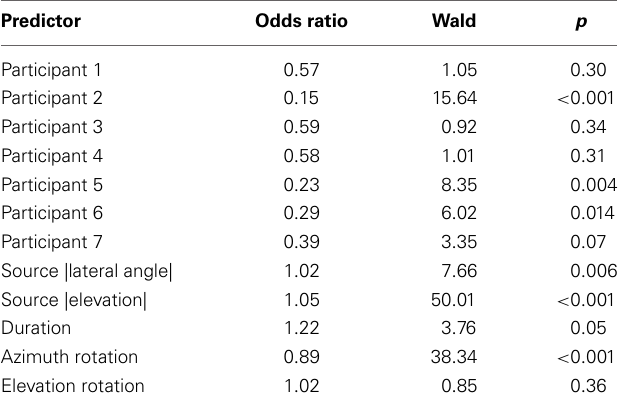
Table 3 | Results of multiple logistic regression predicting front/back confusion